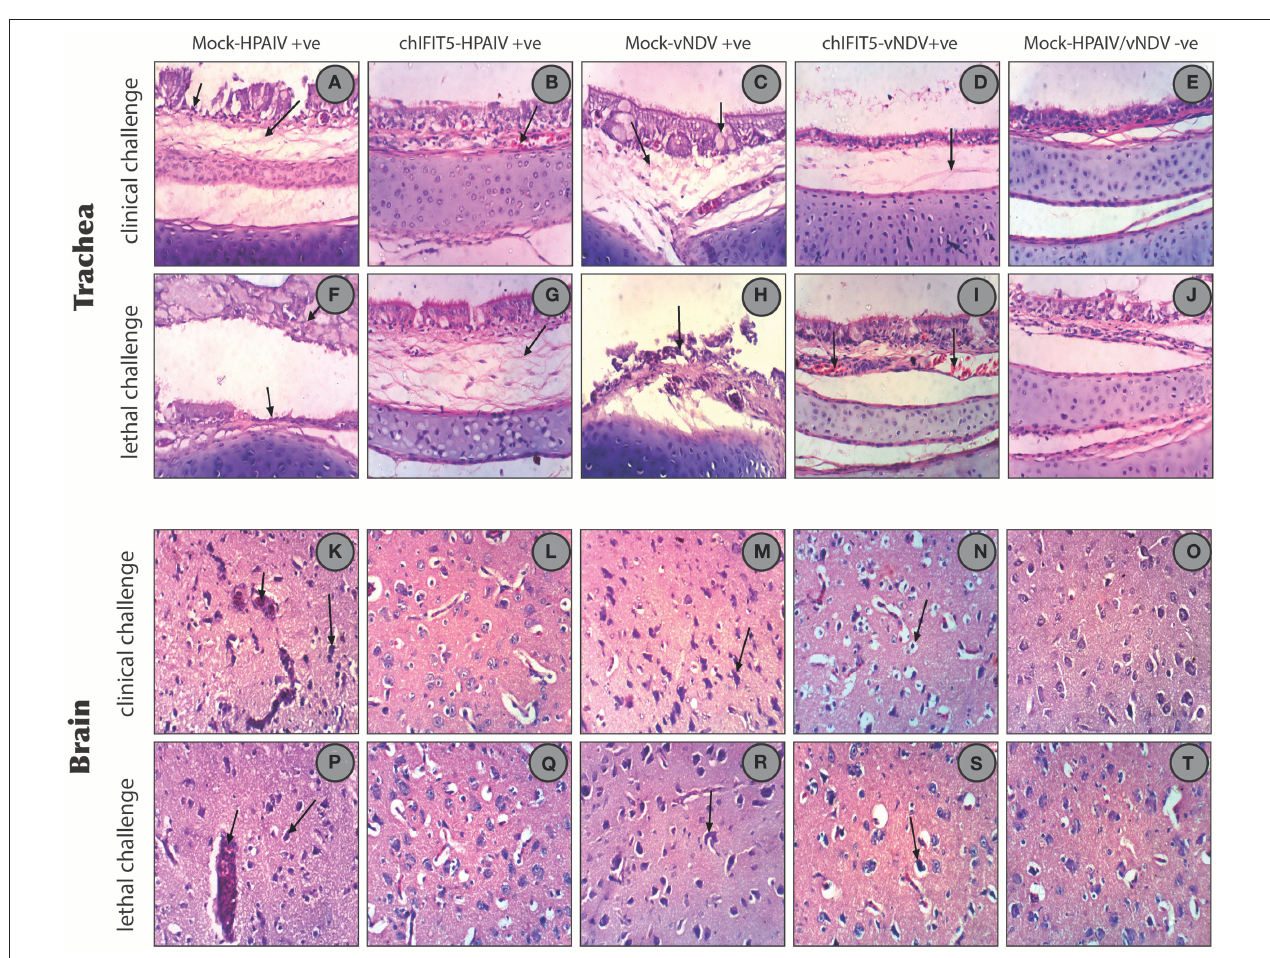
FIGURE 7 | (A) Trachea of chicken infected with HPAIV (clinical challenged) showing focal necrosis of lamina epithelialis (small arrow) and oedema in the lamina propria/submucosa layer (large arrow). (B) Trachea of chicken expressing chIFIT5 and infected with HPAIV showing slight congested blood vessel. (C) Trachea of chicken infected with vNDV (clinical challenged) showing activation of mucous secreting glands (small arrow) and oedema in the lamina propria/submucosa layers (large arrow). (D) Trachea of chicken expressing chIFIT5 and infected with vNDV showing slight oedema in the lamina propria/submucosa layers. (E) Trachea of control chicken showing the normal histological layers. (F) Trachea of chicken infected with HPAIV (lethal challenged) showing focal necrosis of the mucosa (small arrow) and accumulation of mucous exudate in the lumen (large arrow). (G) Trachea of chicken injected expressing chIFIT5 and infected with HPAIV (lethal challenge) showing oedema in the lamina propria/submucosa layers. (H) Trachea of chicken infected with vNDV (lethal challenge) showing necrosis of the mucosa (arrow). (I) Trachea of chicken expressing chIFIT5 and infected with vNDV (lethal challenge) showing congested blood vessels. (J) Trachea of control chicken showing the normal histological layers. (K) Brain of chicken expressing chIFIT5 and infected with HPAIV (clinical challenge) showing congestion of cerebral blood vessel (small arrow) and necrosis of neurons (large arrow). (L) Brain of chicken expressing chIFIT5 and infected with HPAIV (clinical challenged) showing no histopathological changes. (M) Brain of chicken expressing chIFIT5 and infected with HPAIV (clinical challenged) showing necrosis of neurons (arrow). (N) Brain of chicken expressing chIFIT5 and infected with vNDV (clinical challenge) showing cellular oedema. (O) Brain of control chicken showing no histopathological changes. ( P ) Brain of chicken expressing chIFIT5 and infected with HPAI (lethal challenge) showing congestion of cerebral blood vessel (small arrow) and necrosis of neurons (large arrow). (Q) Brain of chicken expressing chIFIT5 and infected with HPAIV (lethal challenged) showing no histopathological changes. (R) Brain of chicken expressing chIFIT5 and infected with vNDV (lethal challenged) showing necrosis of neurons and neuronophagia (arrow). (S) Brain of chicken expressing chIFIT5 and infected with vNDV (lethal challenged) showing necrosis of some neurons and neuronophagia. (T) Brain of control chicken showing no histopathological changes. (All images were stained with H&E and are imaged at